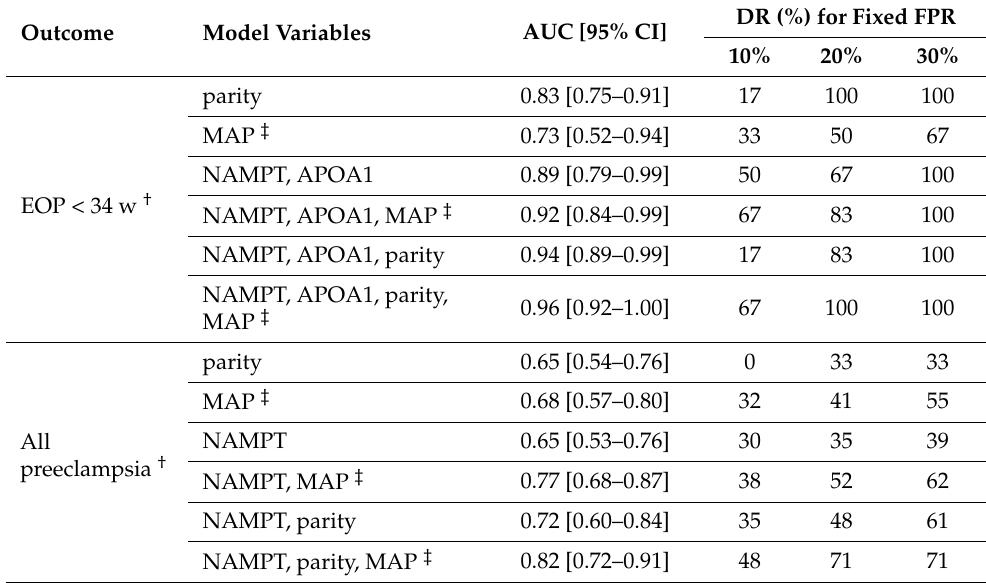
Table 7. Prognostic accuracy * for preeclampsia (PE) and early onset (<34 w) (EOP).